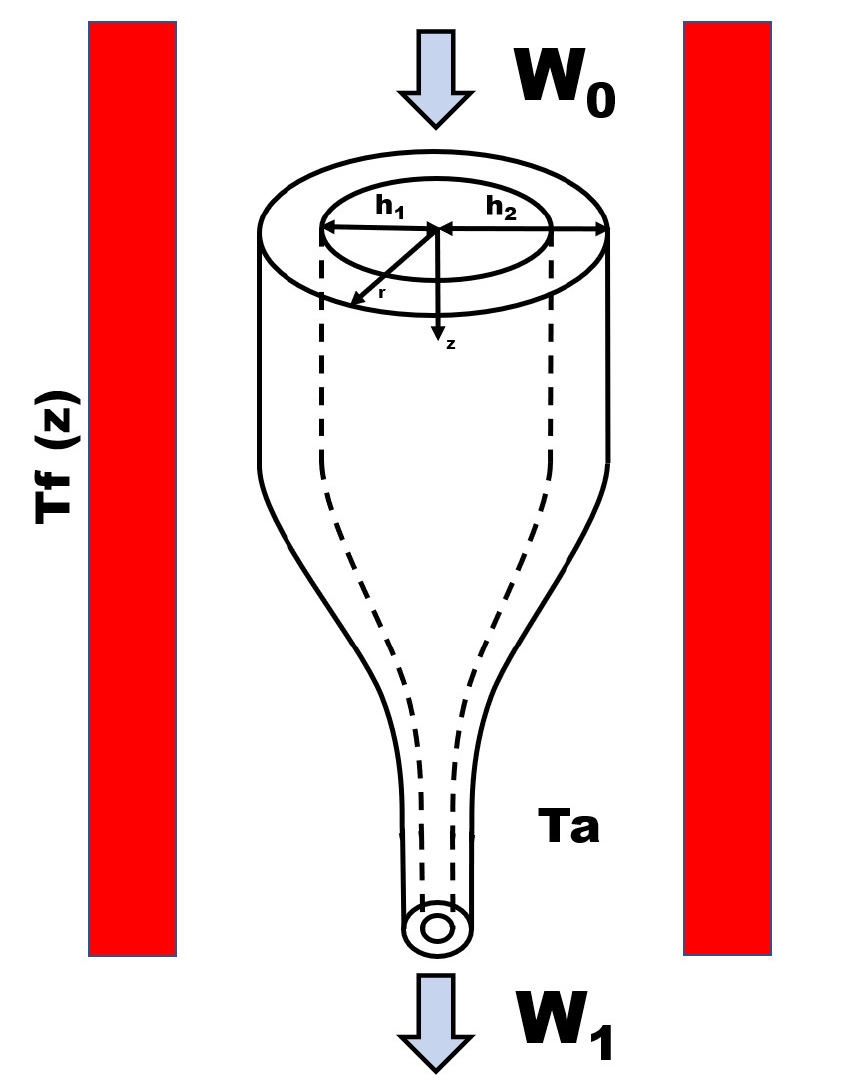
Figure 1. Schematic diagram of the drawing process of an optical glass capillary. The furnace temperature depends on the axial position z , and is indicated by T f , while the furnace ambient temperature is indicated by T a